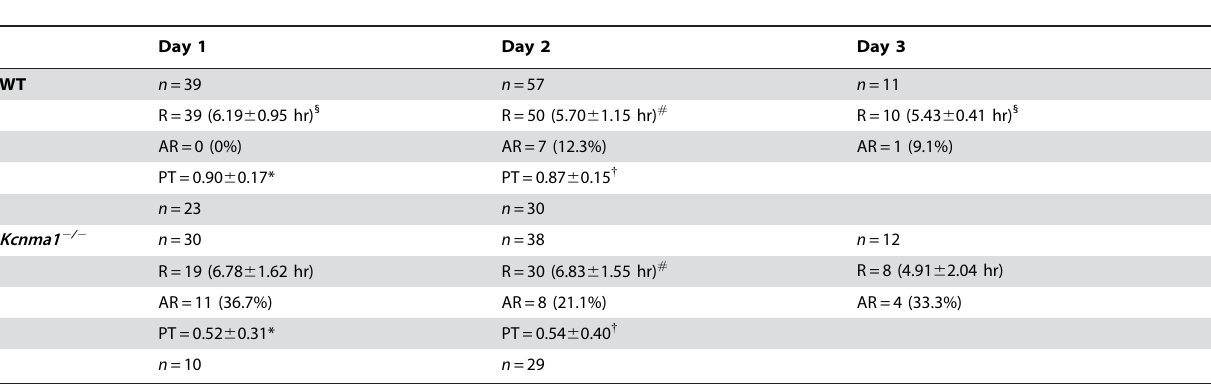
Table 1. Analysis of WT and Kcnma1 2 / 2 SFR